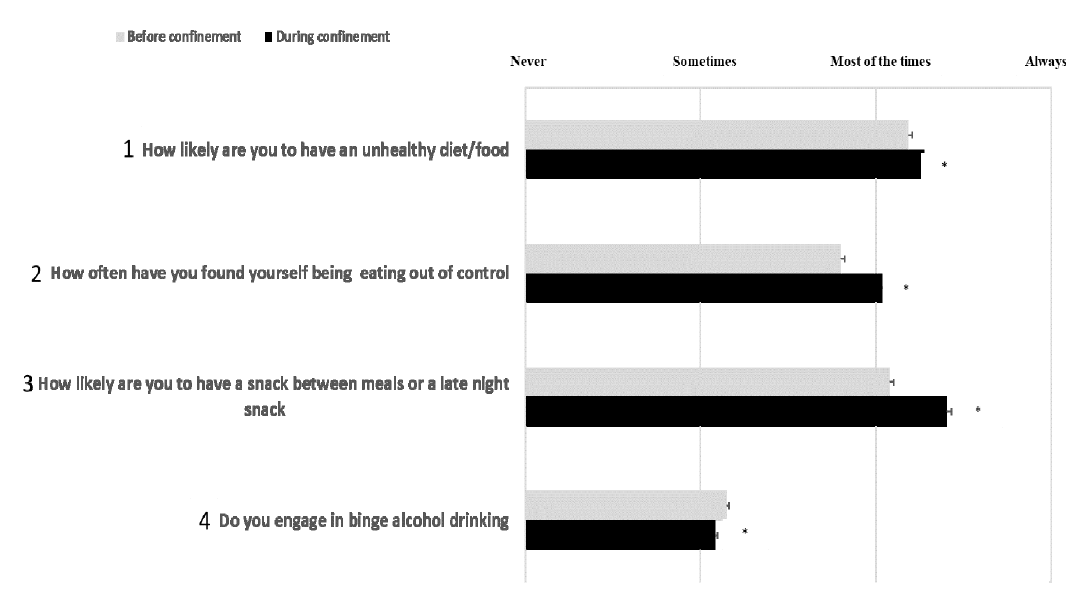
Figure 1. Participants’ scores in response to the related diet behaviour questions. *: Significant di ff erences between “before” and “during” COVID-19 home confinement period.